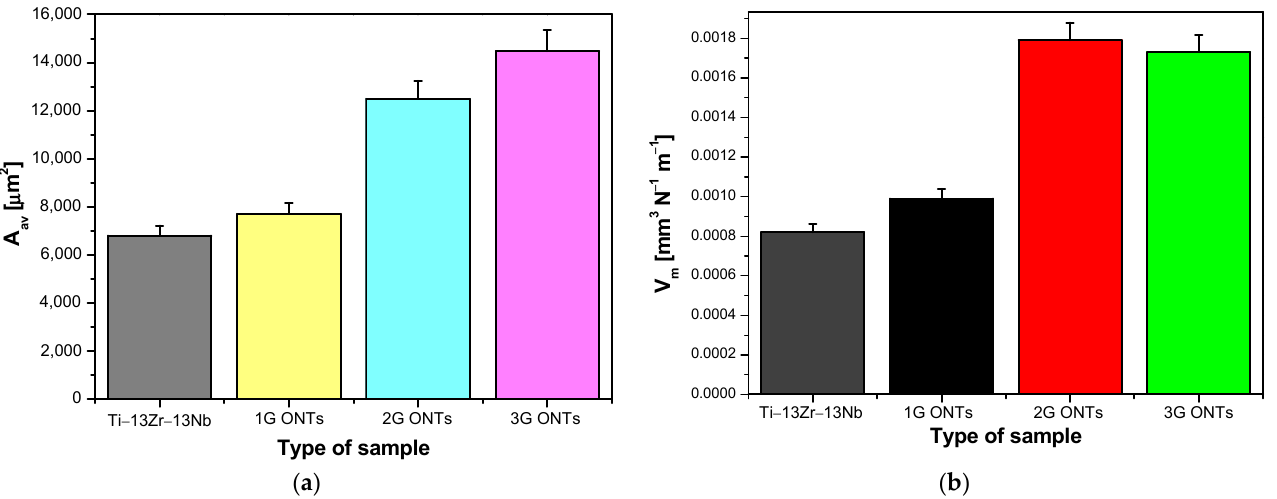
Figure 8. Parameters obtained after the tribological wear test in the ball-on-flat system for the Ti– 13Zr–13Nb alloy before and after anodizing: ( a ) average wear surface area (A av ); ( b ) average material volume consumption (V m ).